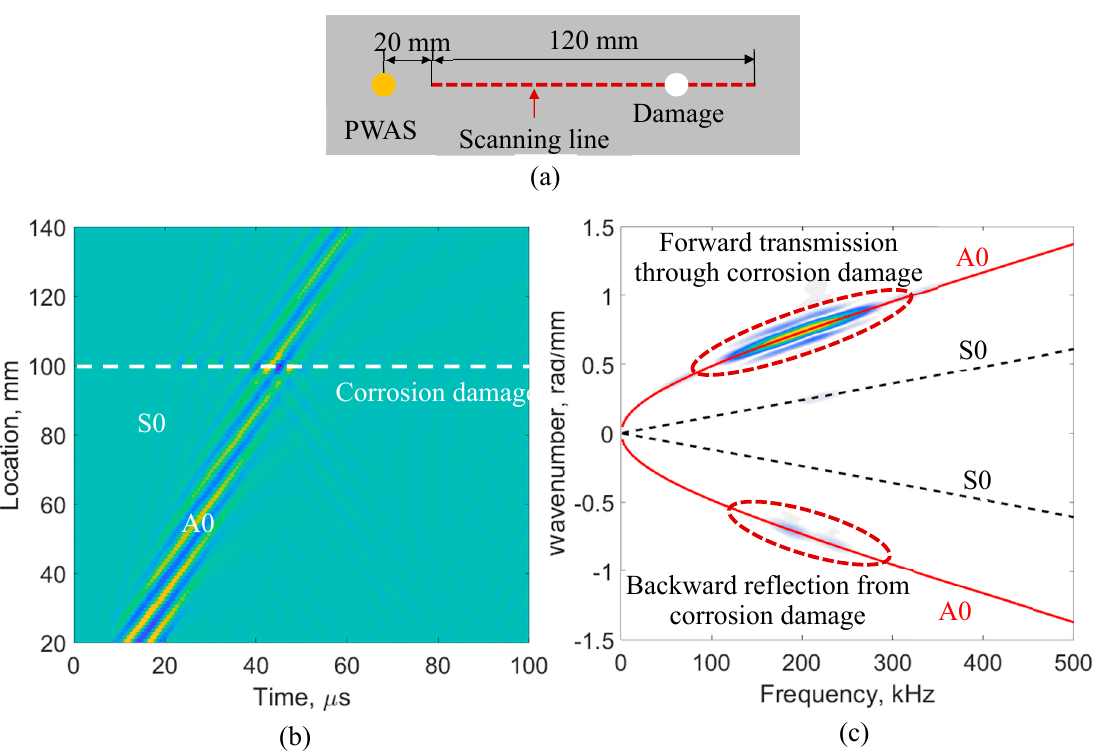
Figure 5. SLDV line scan for a 2.032-mm 2024-T3 aluminum plate: ( a ) schematic of the SLDV line scan; ( b ) time–space wavefield at 200 kHz; ( c ) frequency–wavenumber dispersion curves.